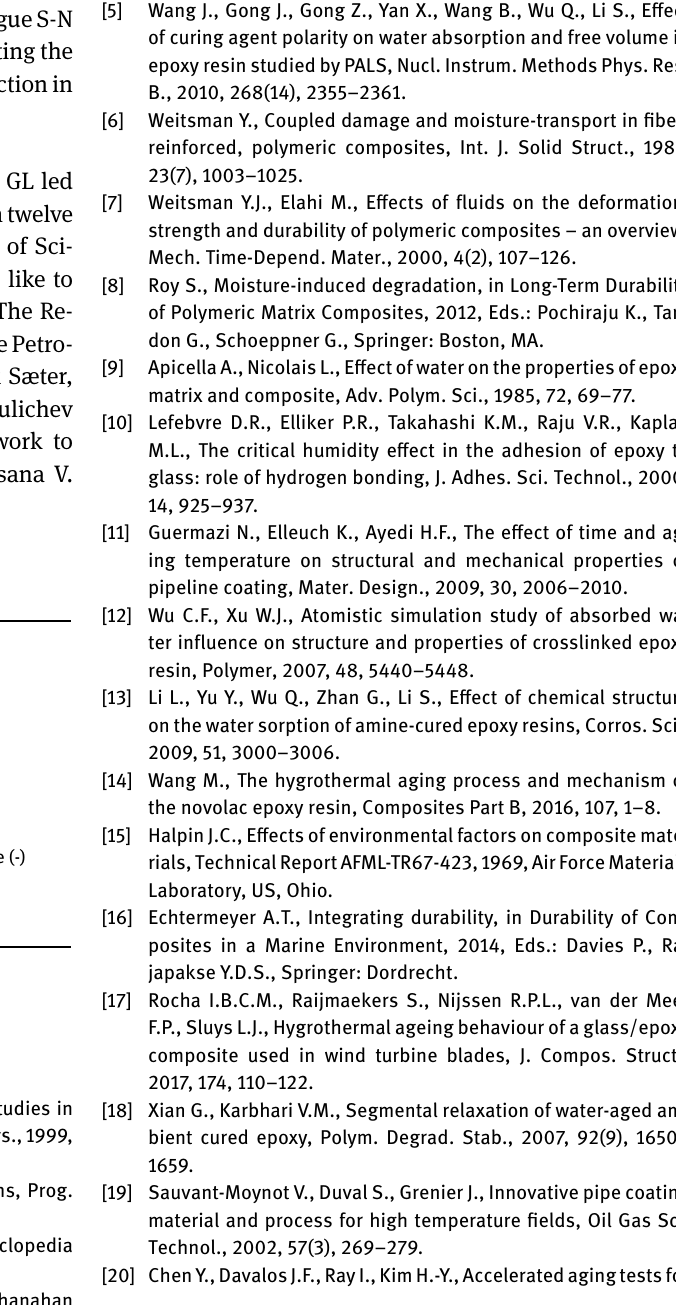
Wet (linear predicted from static